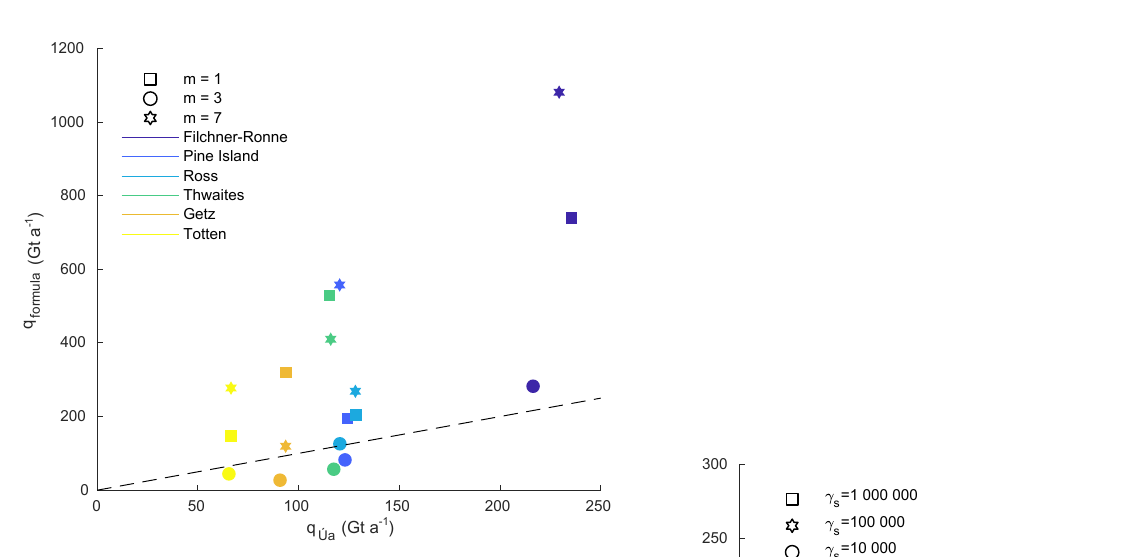
Figure B3. Comparison of fluxes calculated with Úa ( x axis) and with the analytical flux formula ( y axis, using θ 1 ), integrated along the grounding lines of the ice shelves indicated in the legend. Sym- bols indicate the different sliding law exponents m = 1,3,7. All other parameters agree with the reference run (indicated by a cir- cle). The dashed line shows where fluxes calculated with Úa and predicted by the formula would agree.